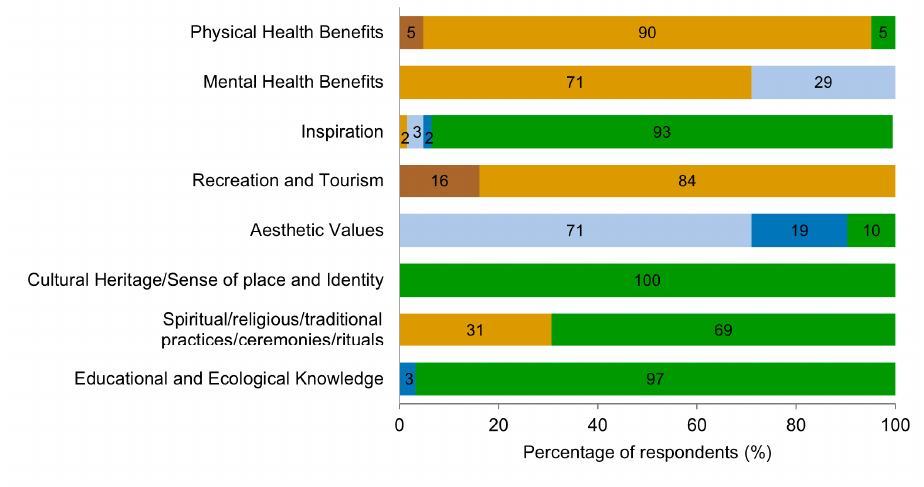
Figure 4. Water levels in the Beas River at which most CES are gained in both study sites.